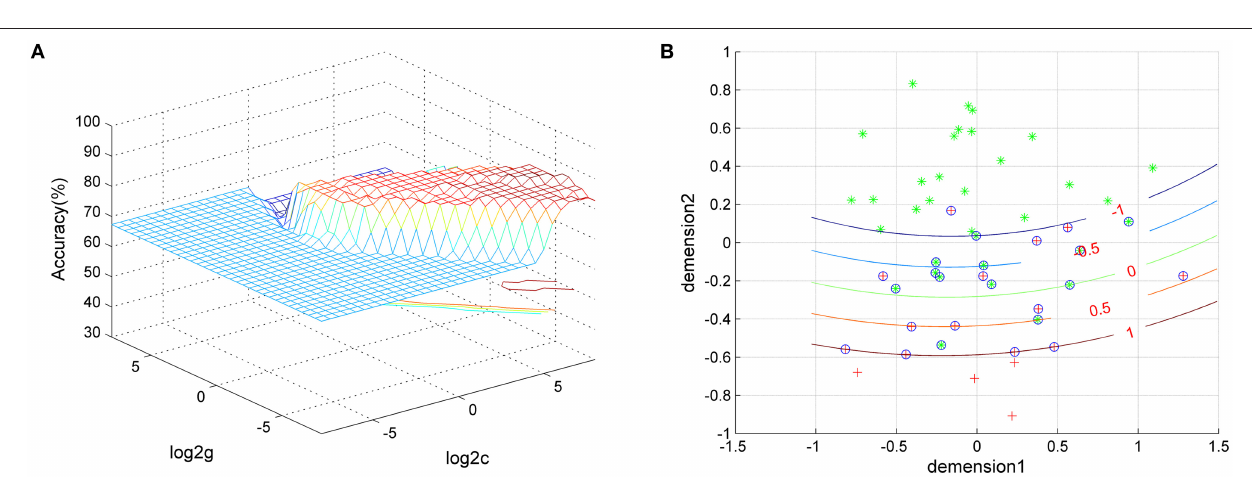
FIGURE 6 | Visualization of the classification using the combination of fALFF values of the left superior MPFC and the right superior frontal gyrus/middle frontal gyrus through SVM. (A) SVM parameter results with 3D view. (B) Classified map of the results. Green crosses represent GI-MDD patients and red crosses represent GI-MDD patients. fALFF , fractional amplitude of low-frequency fluctuation; MPFC , medial prefrontal cortex; SVM , support vector machine; GI-MDD , major depressive disorder with gastrointestinal symptoms; nGI-MDD , major depressive disorder without gastrointestinal